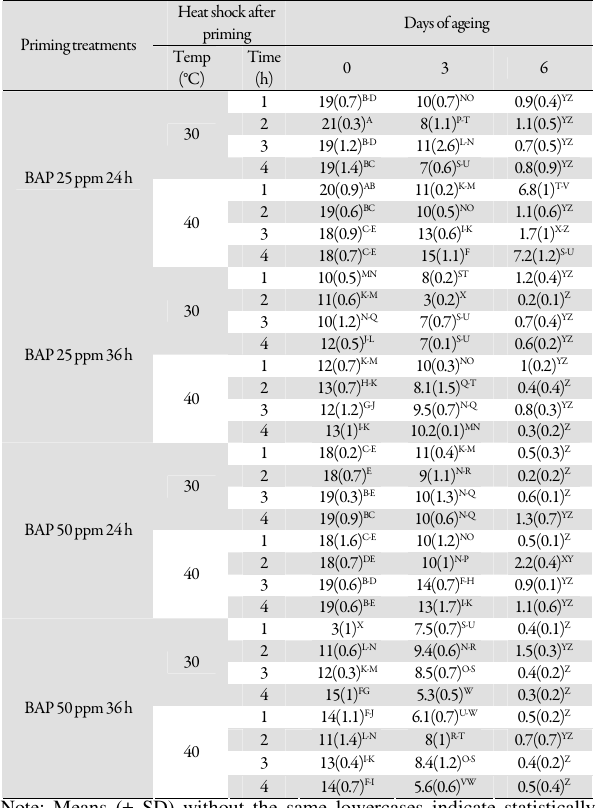
Tab. 2. Timson index (GI) of Tall wheatgrass seeds at different levels of heat shock followed by priming treatments; the LSD0.05 for GI is